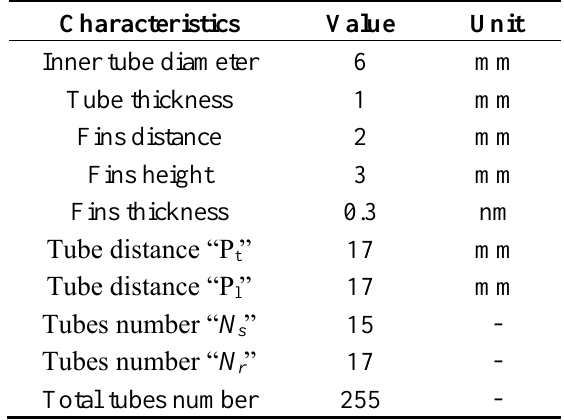
Table 6. Geometric characteristics of R134a component.